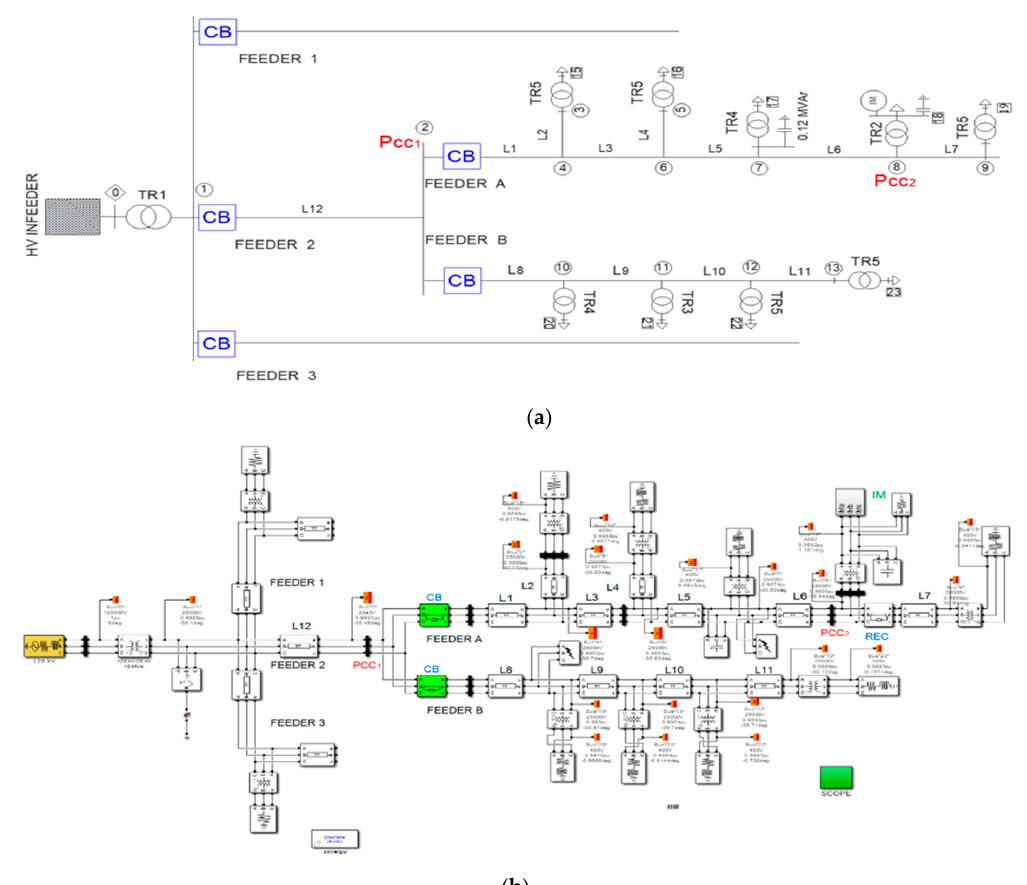
Figure 7. Test system under study. ( a ) One-line diagram of the test system.; ( b ) Matlab/Simulink implementation of the test system.